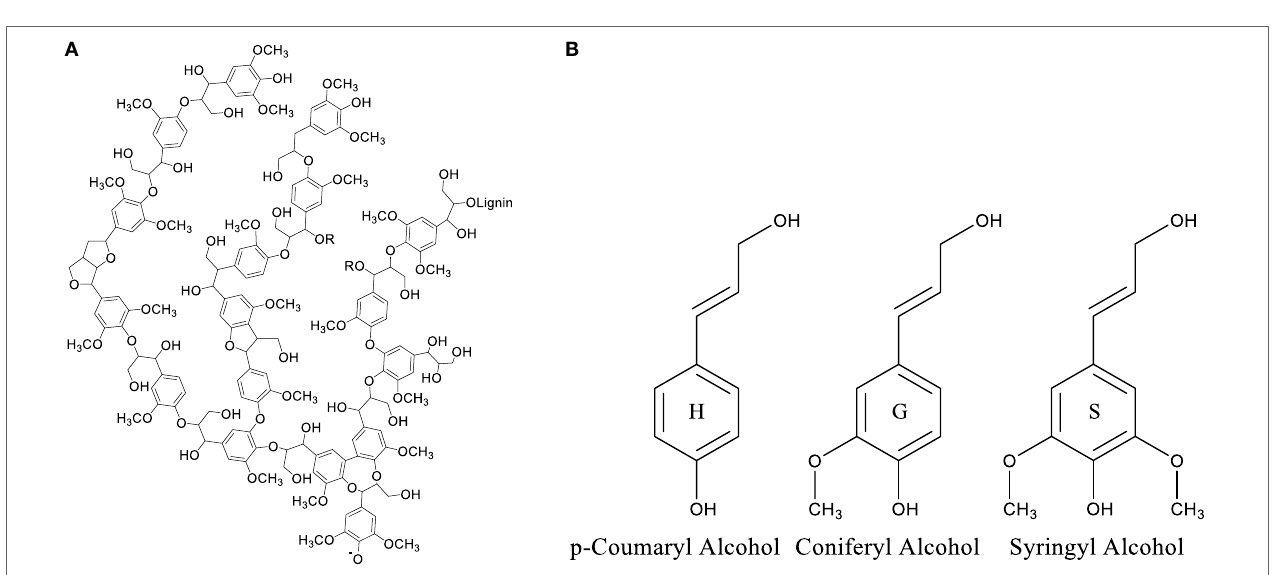
FigUre 5 | (a) Theoretical representation of the structure of a lignin molecule and (B) the structures of the monolignol units used to polymerize lignin.